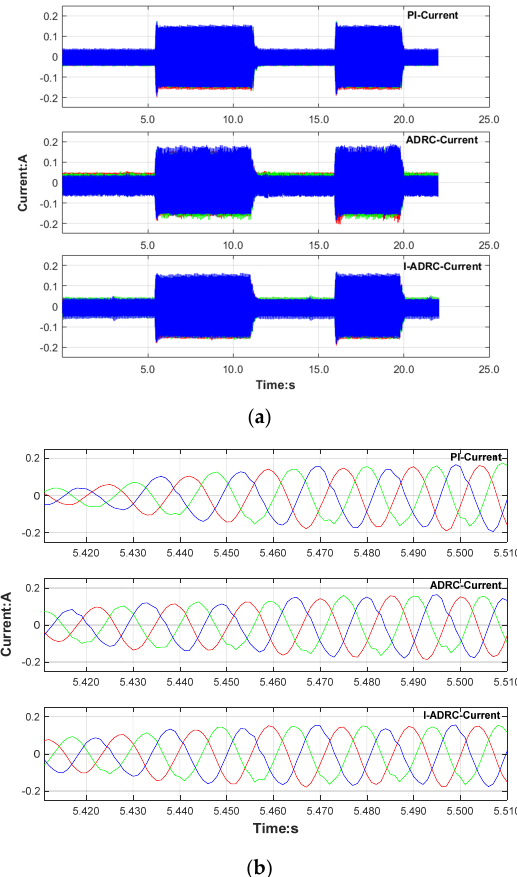
Figure 11. Three phase current test curve: ( a ) complete current curve and ( b ) local current curve. The test results of speed and current are consistent with simulation results.